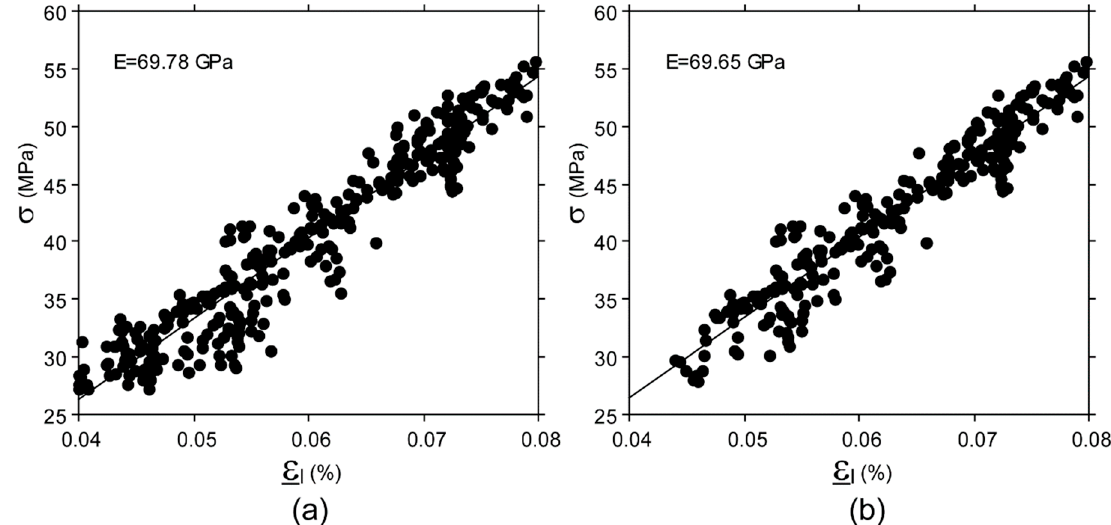
Figure 5. E value determined for one specimen. ( a ) Regression slope obtained using a subset size of 60 × 60 pixels. ( b ) Regression slope obtained using a subset size of 60 × 60 pixels and image pre-selection.